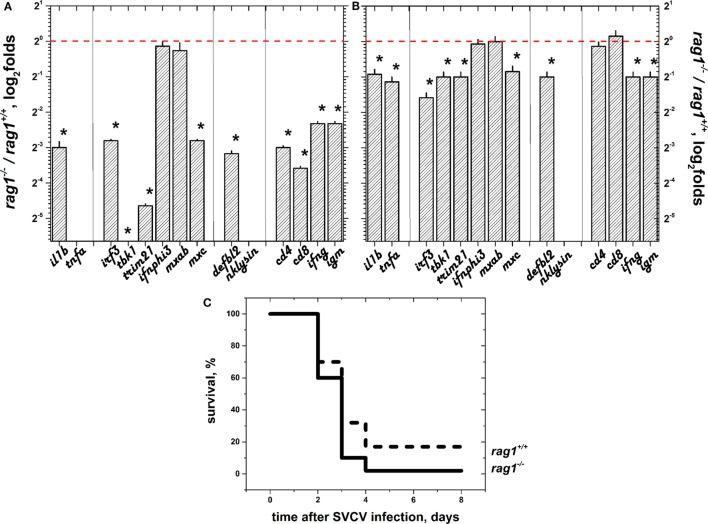
Selected gene sets (sGS) were downregulated in rag1−/− egg embryos but were similar in early hatched larvae and both showed high mortalities when infected by spring viremia carp virus (SVCV). (A) Expression folds in embryo eggs 1 day after fertilization (n = 60). Reverse transcriptase and quantitative polymerase chain reaction data were first normalized by the formula, expression of each gene/expression of ef1a. Differential folds were then calculated by the formula, normalized expression of each rag1−/− gene/normalized expression of each rag1+/+ gene. Tbk1 fold was lower than 2−6 (not shown). Tnfa and nklysin were not done. Red dashed line, onefold boundary. *Statistically different from onefold with p < 0.05 by the t-test. (B) Expression folds in hatched larvae 3 days after fertilization (n = 45) calculated as in (A). (C) Kaplan–Meier survival curves of naïve rag1−/− (n = 90) and rag+/+ (n = 90) recently hatched larvae after bath infection in 104 pfu of SVCV per ml (n = 2) at 22°C (optimal replication for SVCV). Differences between rag1−/− and rag+/+ survival curves of SVCV-infected larvae as determined by the Gehan–Breslow–Wilcoxon test were significant with p < 0.05 (*). Solid lines, rag1−/− larvae. Dashed lines, rag+/+ larvae.